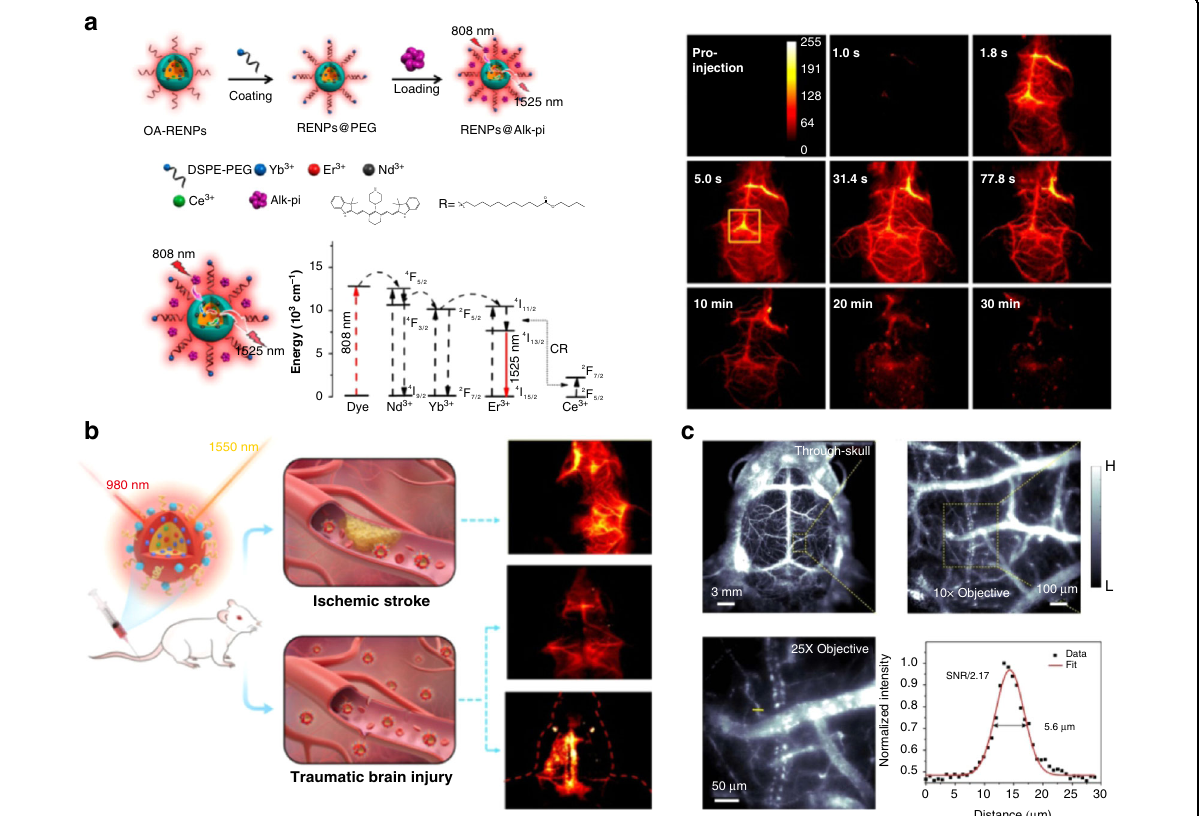
Fig. 4 Different sensitization strategies to improve the luminescent brightness of RENPs for fl uorescence imaging in the brain. a Schematic diagram of constructing dye-sensitized RENPs (left). Fluorescence imaging of brain vasculature after injection of RENPs@Alk-pi under 808 nm excitation (right). Reprinted with permission from ref. 62 . Copyright 2021 American Chemical Society. b QDs-sensitized RENPs for high-contrast of dynamic cerebrovascular changes in traumatic brain injury. Reprinted with permission from ref. 64 . Copyright 2021 American Chemical Society. c Bacteriochlorin-sensitized RENPs for intravital microscopic imaging of the cerebral vessels. Reprinted with permission from ref. 65 . Copyright 2021 Nature Publishing